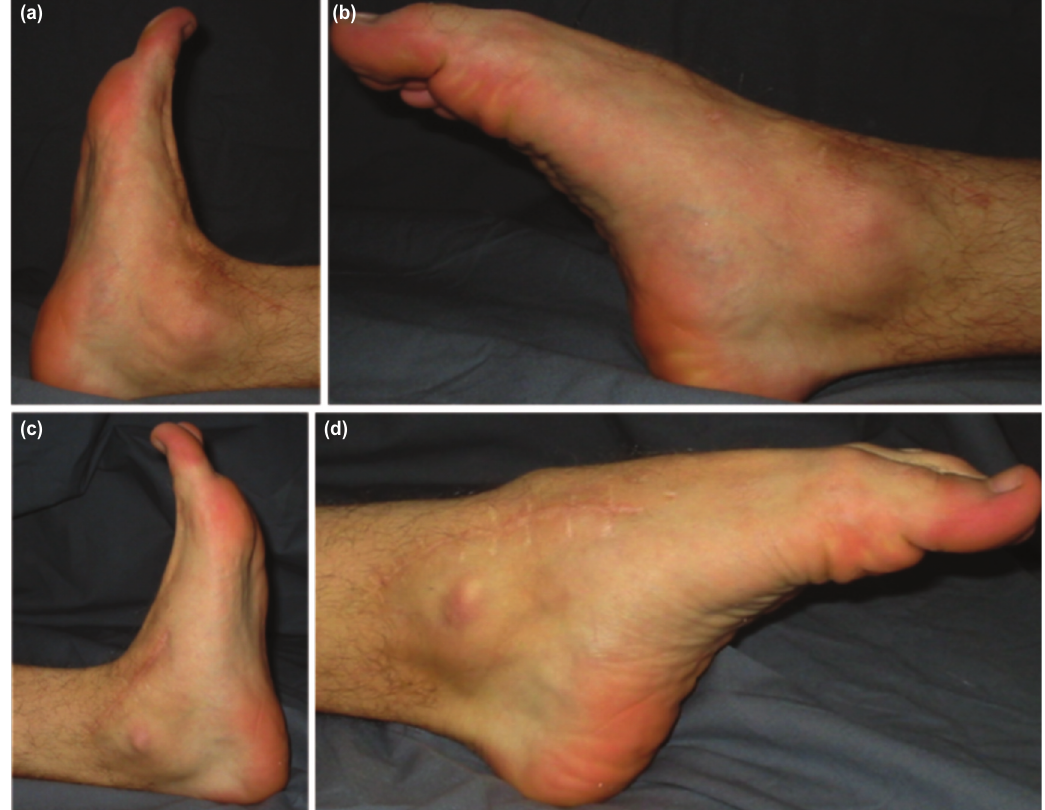
Photographs showing range of motion of both feet at 36 months follow-up. (a) dorsal flexion. (b) plantar flexion of the right Fig. 3: foot. (c) dorsal flexion. (d) plantar flexion of the left